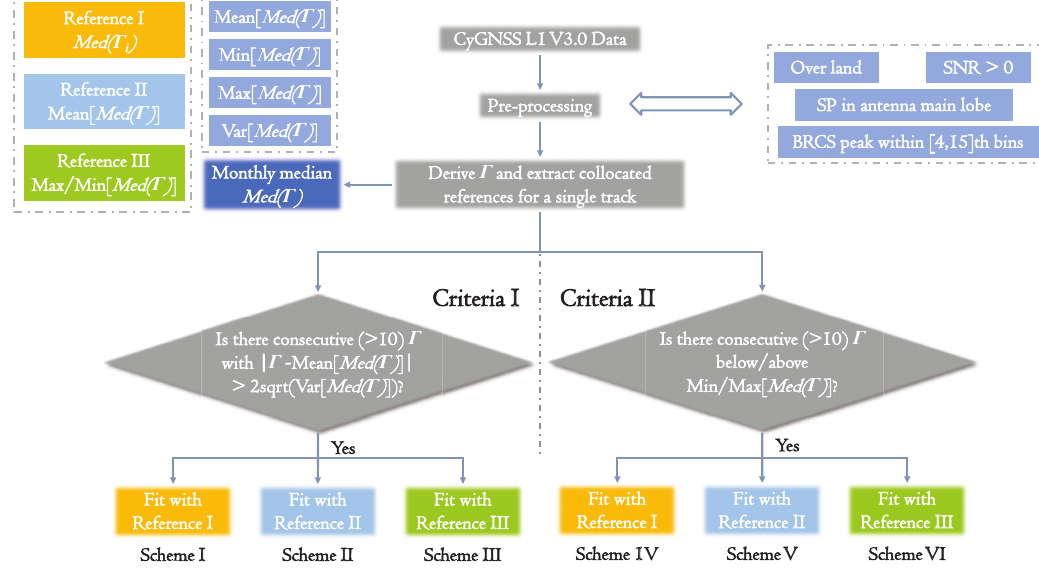
Figure 2. Flowchart of the proposed calibration